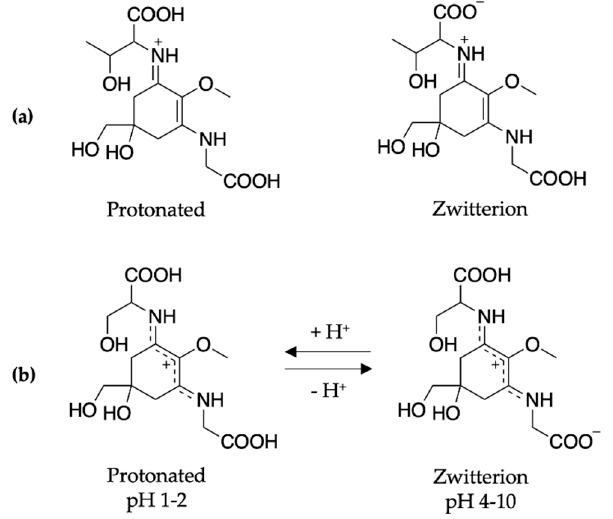
Figure 18. ( a ) Structure of porphyra-334 elucidated by Klisch et al. [134], and ( b ) structure of shinorine at different pHs determined by Matsuyama et al. [129] .